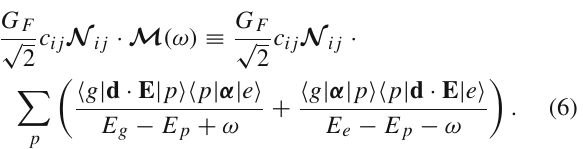
and for α parity-even